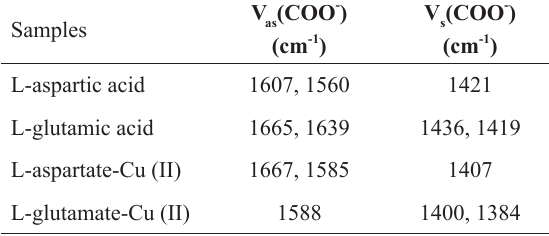
Caraboxylate band shifts for L-glutamic acid, L-aspartic acid and metal-amino acid complexes L-glutamate-Cu (II) and L-aspartate-Cu (II), the displacements were compared as described by Baran et al.